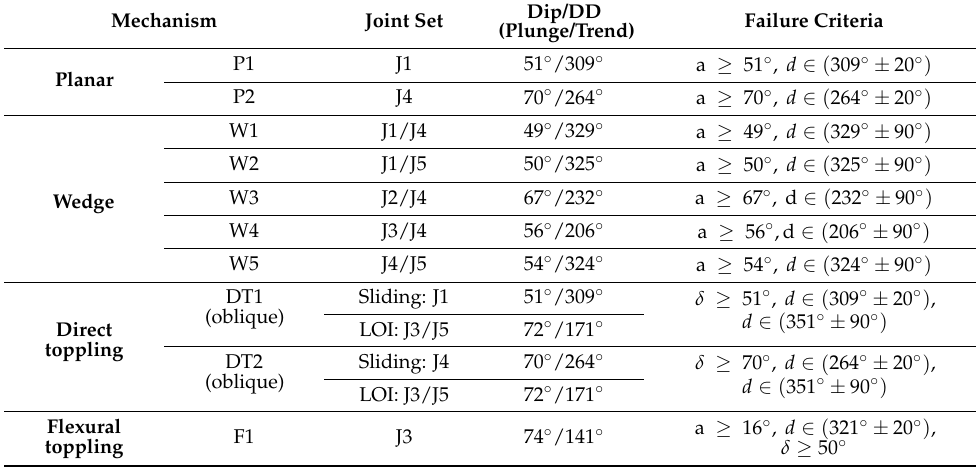
Table 3. Slope failure criteria associated with different rock instability mechanisms, in which a is slope apparent dip, d is slope dip direction, δ is slope real dip, and a s is the apparent dip of the slip limit plane for flexural toppling analysis. Mechanism Joint Set Dip/DD (Plunge/Trend) Failure Criteria Planar